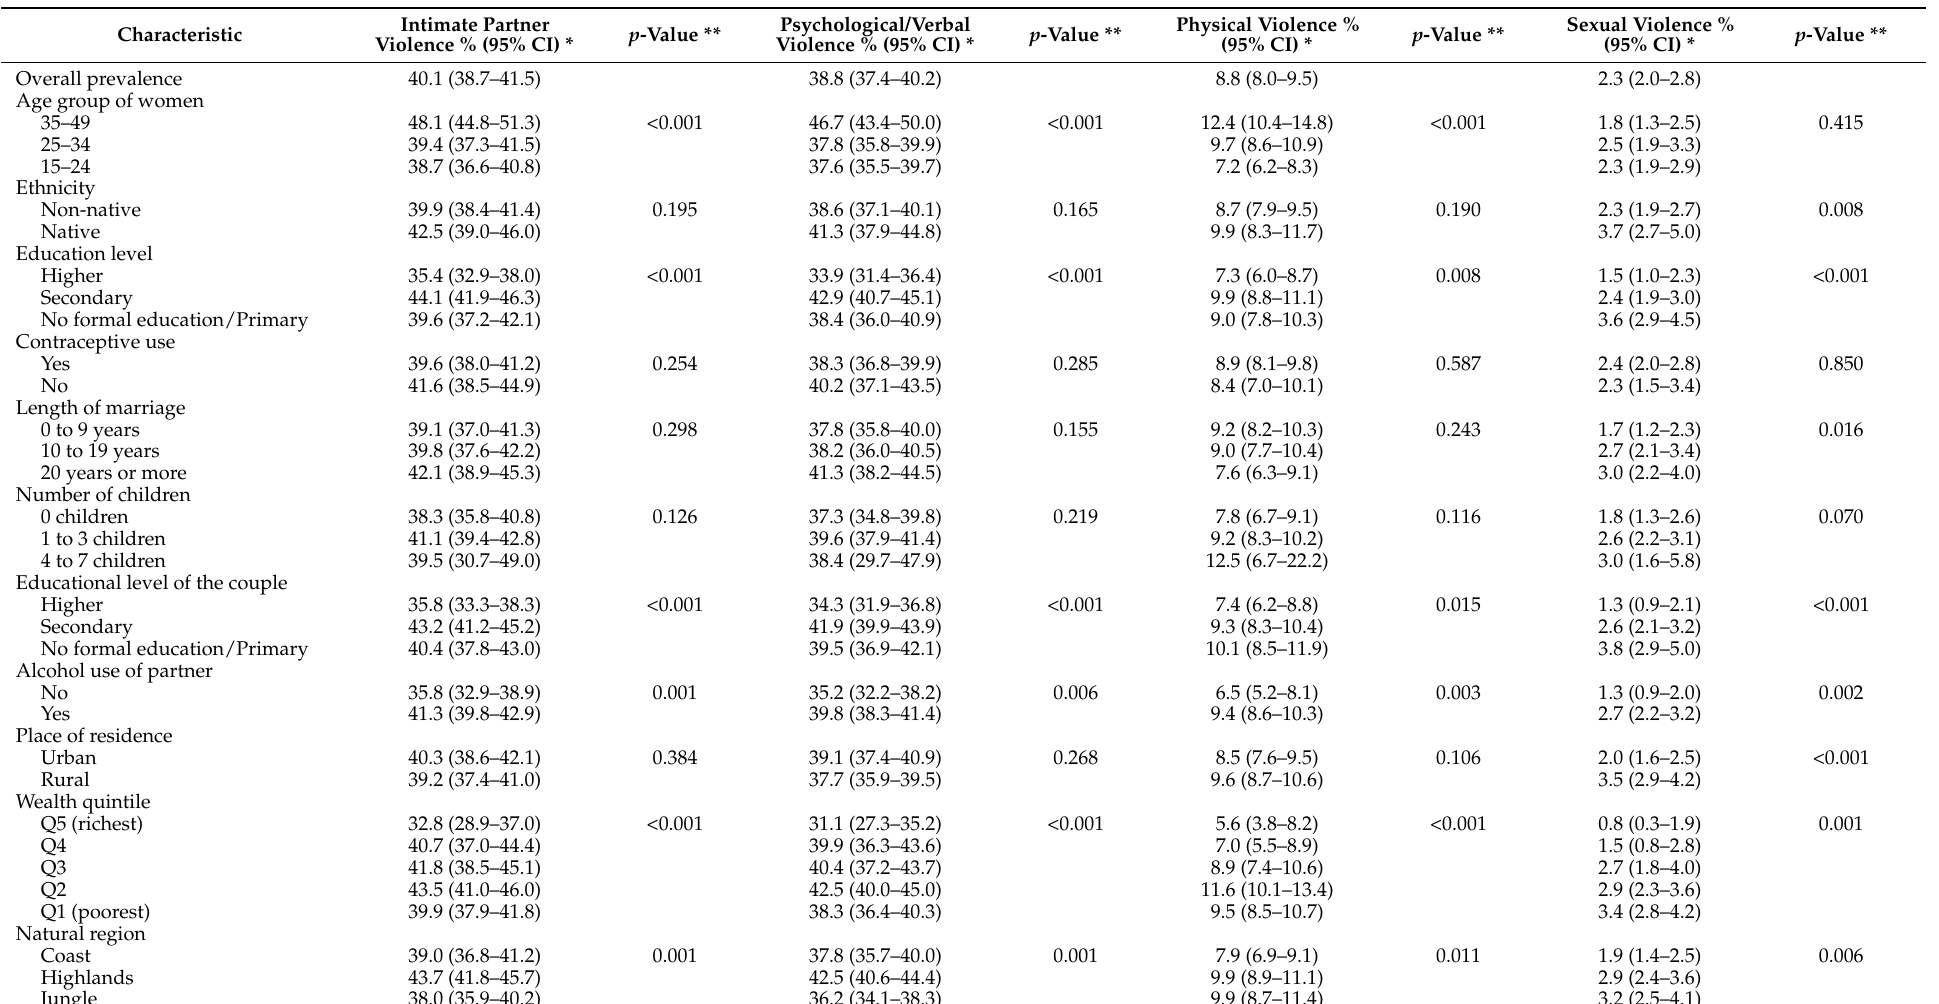
Table 3. Characteristics of Peruvian women aged 15 to 49 years included in the study according to types of